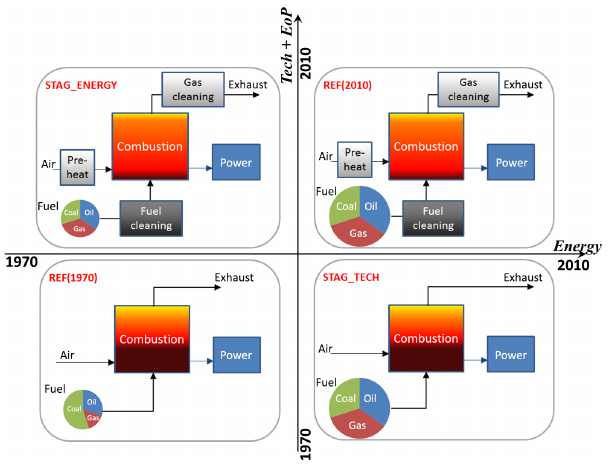
Figure 2. Schematic of the considered emission scenarios: REF(1970), REF(2010), STAG_ENERGY and STAG_TECH. The x axis represents the change in energy consumption from 1970 to 2010 (shown also by the increasing size of the fuel pie charts), while the y axis represents the change in abatement measures (EoP) and technologies from 1970 to 2010. The STAG_TECH sce- nario has the same technologies and abatements of the REF(1970) scenario, but assumes increased energy consumption and differ- ent fuel mix (as shown in the pie chart composition) as in 2010. The STAG_ENERGY scenario considers the energy consumption of 1970 but it includes all the technologies, abatements, fuel mix and energy efficiency of